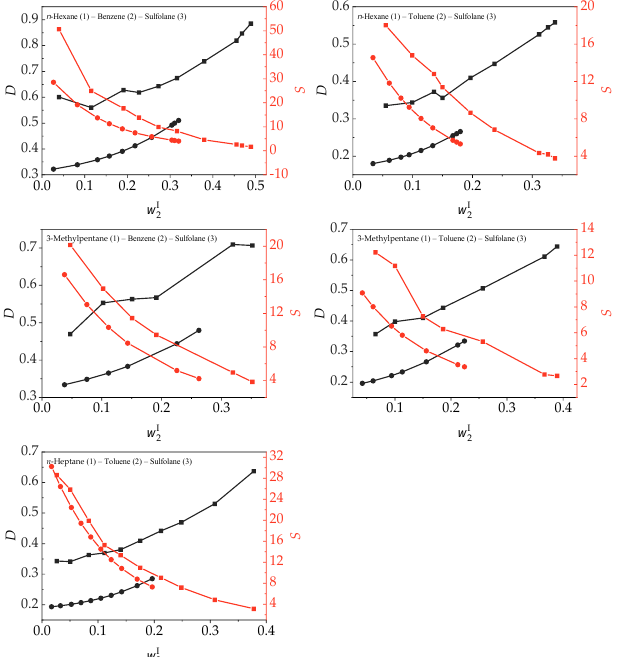
Figure 5. The distribution coefficients ( D ) and separation factors ( S ) of benzene and toluene (mass fraction) in the extracted phase (II). ( ■ ) Experimental or reference [30] data; (●) calculated data using the COSMO-RS model.